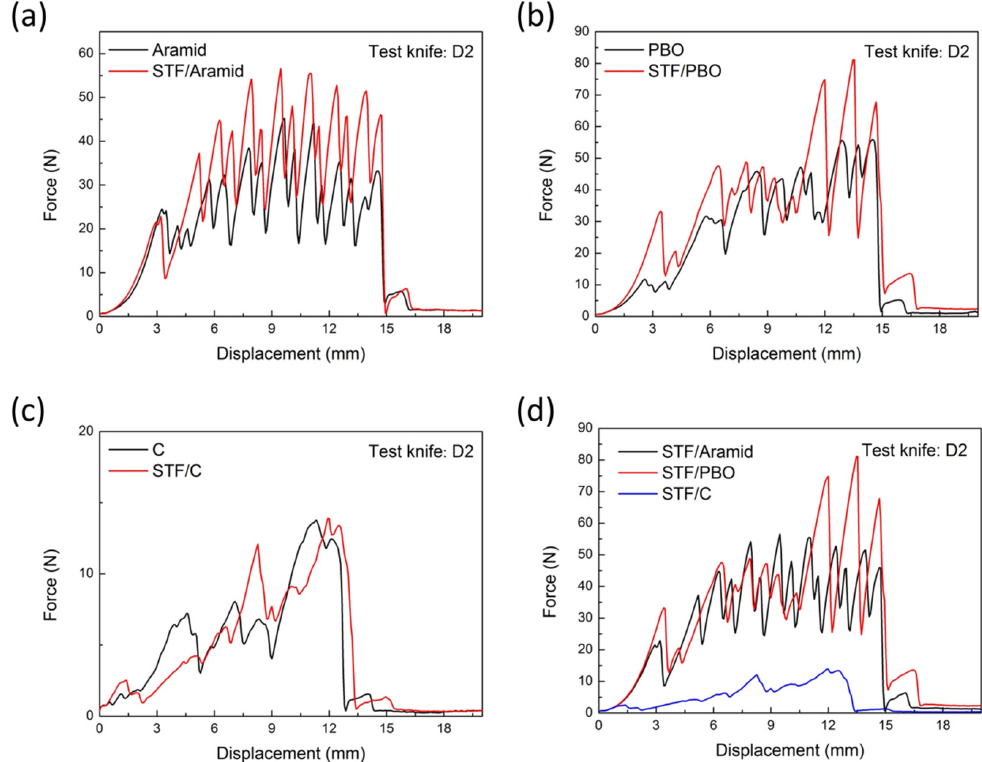
Figure 2. Force-displacement curves of neat and STF-treated fabrics penetrated with D2 tool. ( a ) Aramid-based fabrics; ( b ) PBO-based fabrics; ( c ) C-based fabrics; ( d ) STF-treated fabrics summary. Table 1. Peak piercing force of different fabrics when punctured by D2 knife.